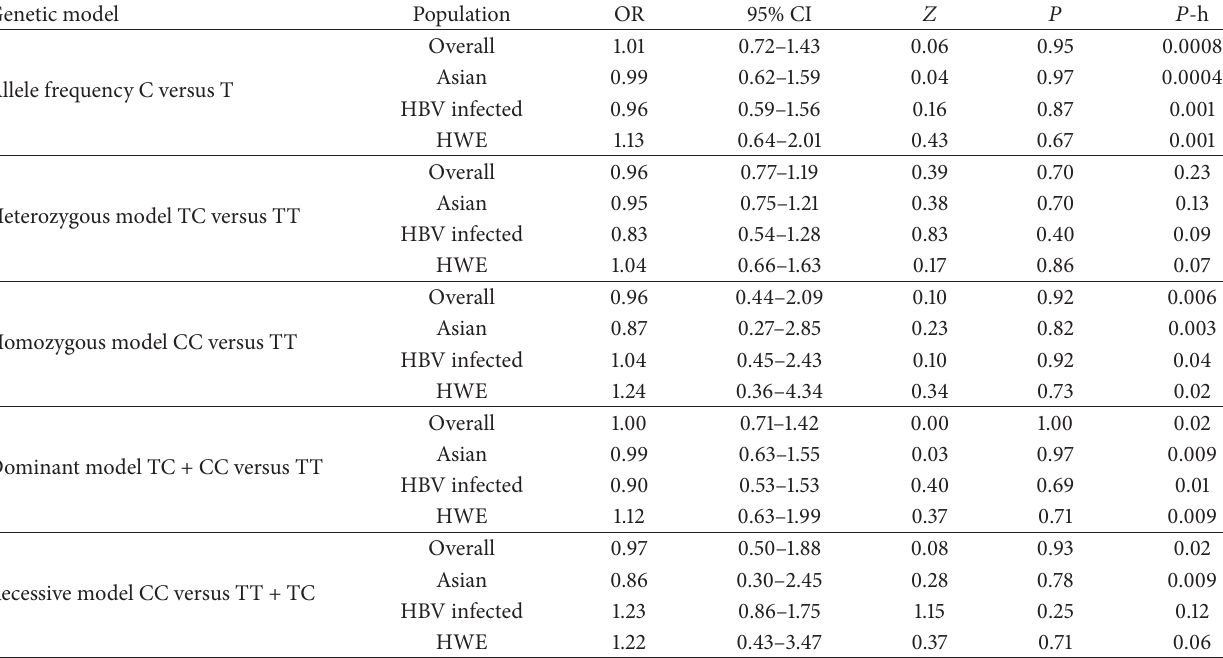
Table 2: Meta-analysis of the association between SNP miR-499 (T > C) rs3746444 and susceptibility to